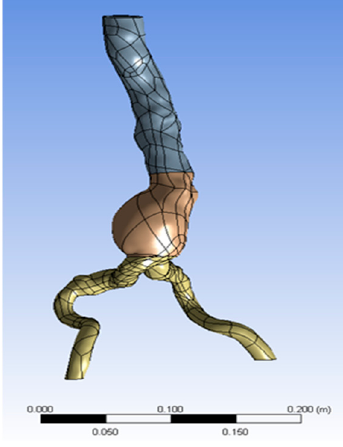
Figure 1. AAA geometry.